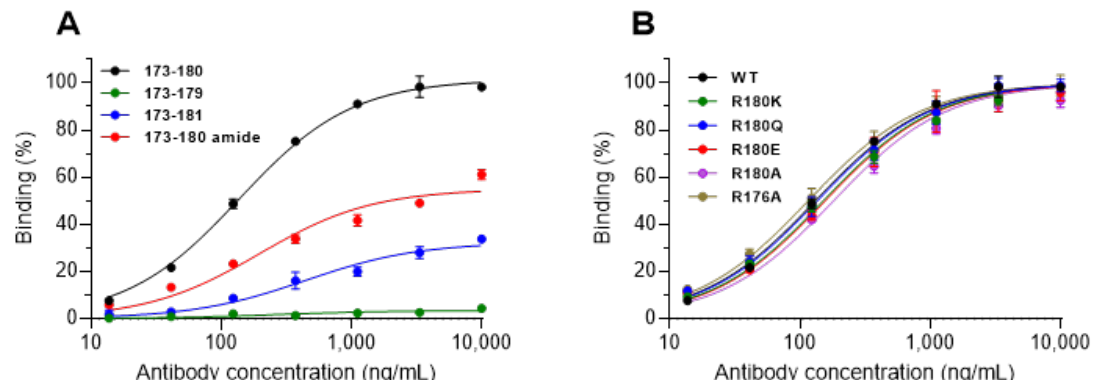
Figure 5. SNAP1 binding to modified SNAP-25 neoepitope peptides. Streptavidin-coated ELISA plates were loaded with ( A ) biotinylated peptides representing either the neoepitope sequence (173–180), a shorter version (173–179), or a longer version (173–181). The modified version (173–180 amide) contained an amide at the end of the peptide instead of a carboxyl group. ( B ) Biotinylated peptides in which the arginines at positions 176 or 180 were substituted with the indicated residues. SNAP1 was added to the bound peptides, and the residual binding was measured. Data are expressed as percent of maximum binding signal obtained with Bio-P1. Points are the mean ± STD of triplicates, fitted by non-linear regression.